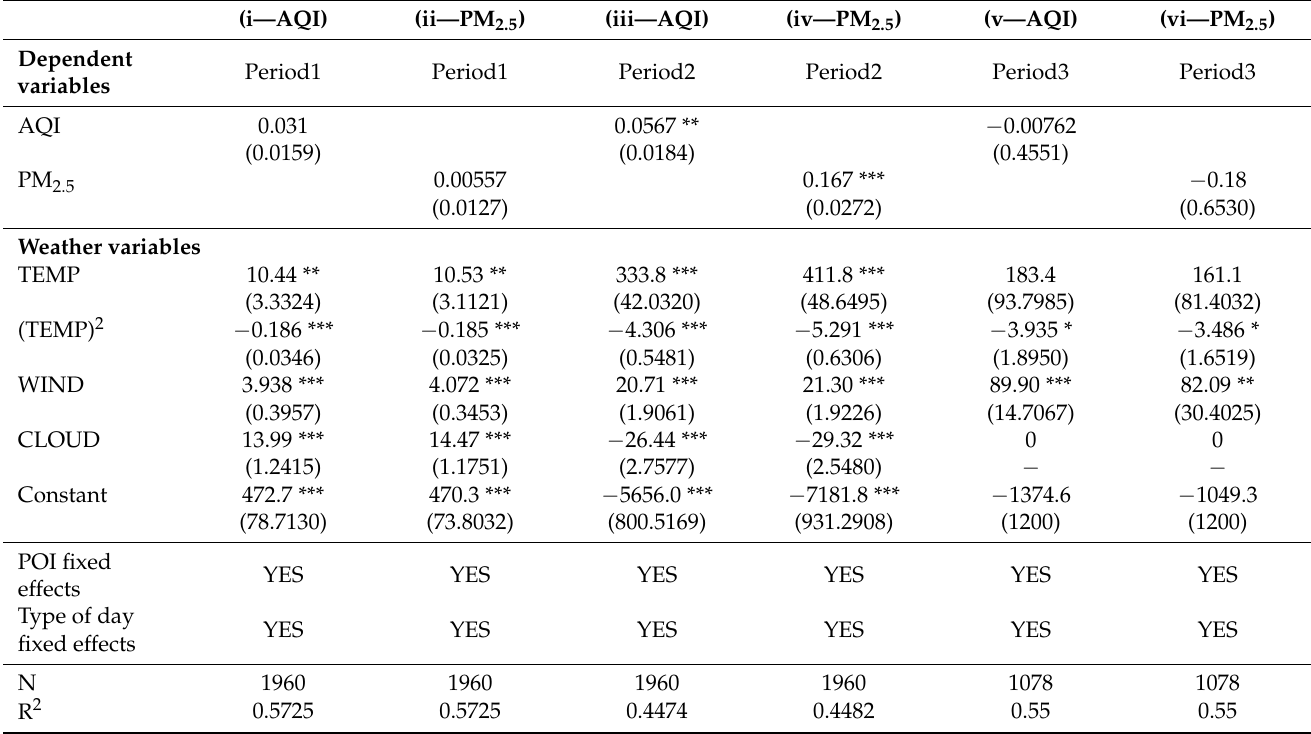
Table A16. Estimations of the effects of air pollution on people’s transport mode subway station POI.